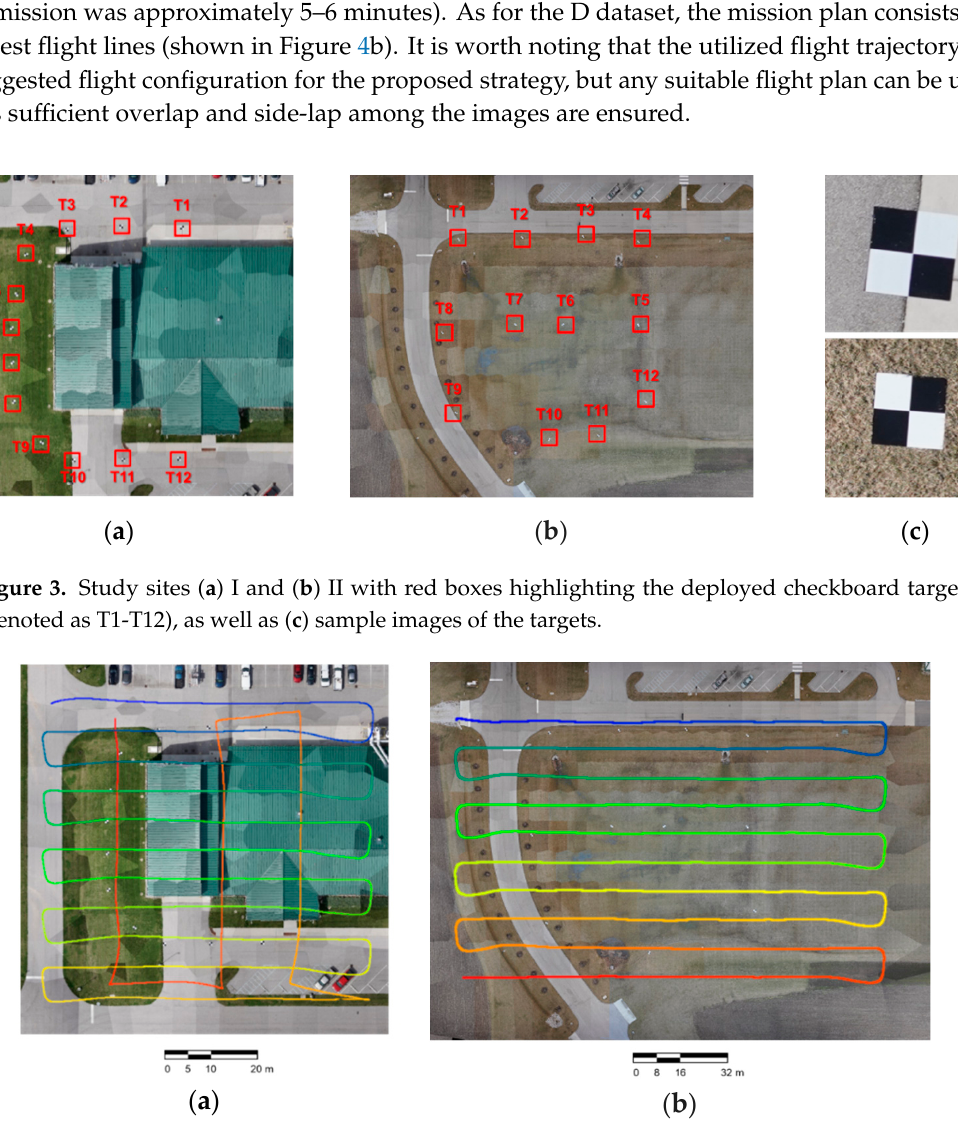
Figure 5. Generated orthophoto and point clouds (colored by height) for the A-1 dataset: ( a ) orthophoto, ( b ) image-based sparse point cloud with 20,000 points, ( c ) image-based dense point cloud with 80,000 points, and ( d ) LiDAR point cloud with 31,000,000 points. ( a ) ( c ) Figure 10. Generated sparse point cloud (colored by height) using ( a ) the default difference of Gaussian (DoG) threshold of 0.007 with 25,000 points, ( b ) smaller DoG threshold of 0.003 with 40,000 points, as well as ( c ) down-sampled sparse point cloud with 3000 points for the A-1 dataset.